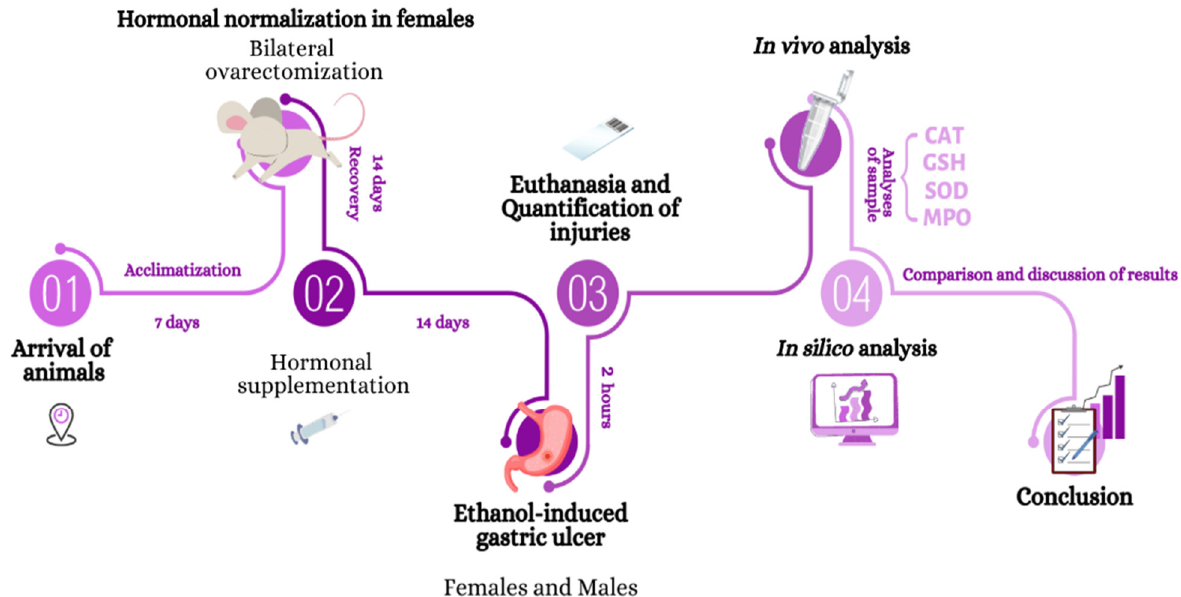
Figure 1. Schematic summary of the experimental design from the arrival of the animals to the analysis of the